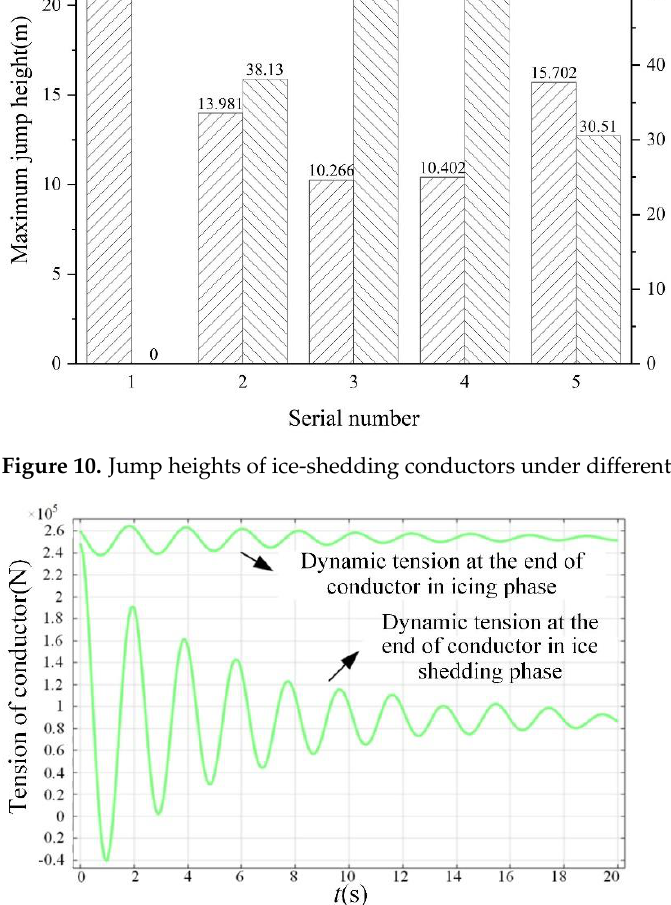
Figure 11. Dynamic tension at the end of the ice-shedding conductor under Scheme